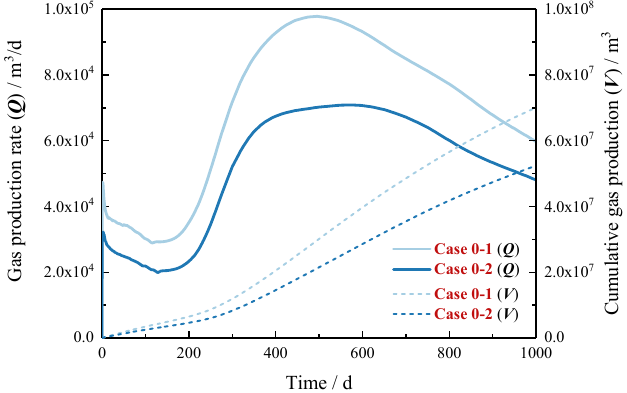
Figure 6. Gas production characteristics for the control group. Table 2. Main production parameters for the control group cases.